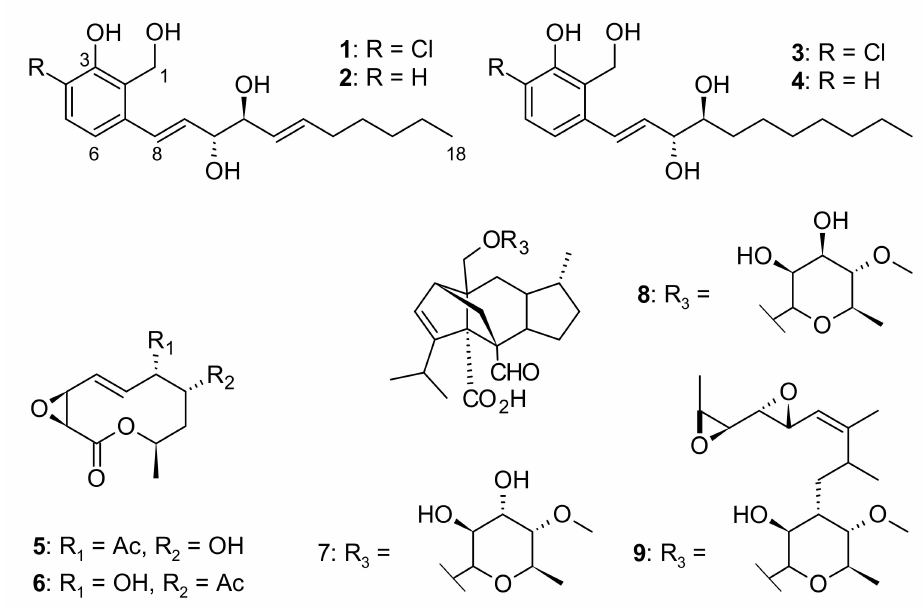
Figure 3. Chemical structures of compounds 1 – 9 isolated from Pseudorhypophila mangenotii CBS